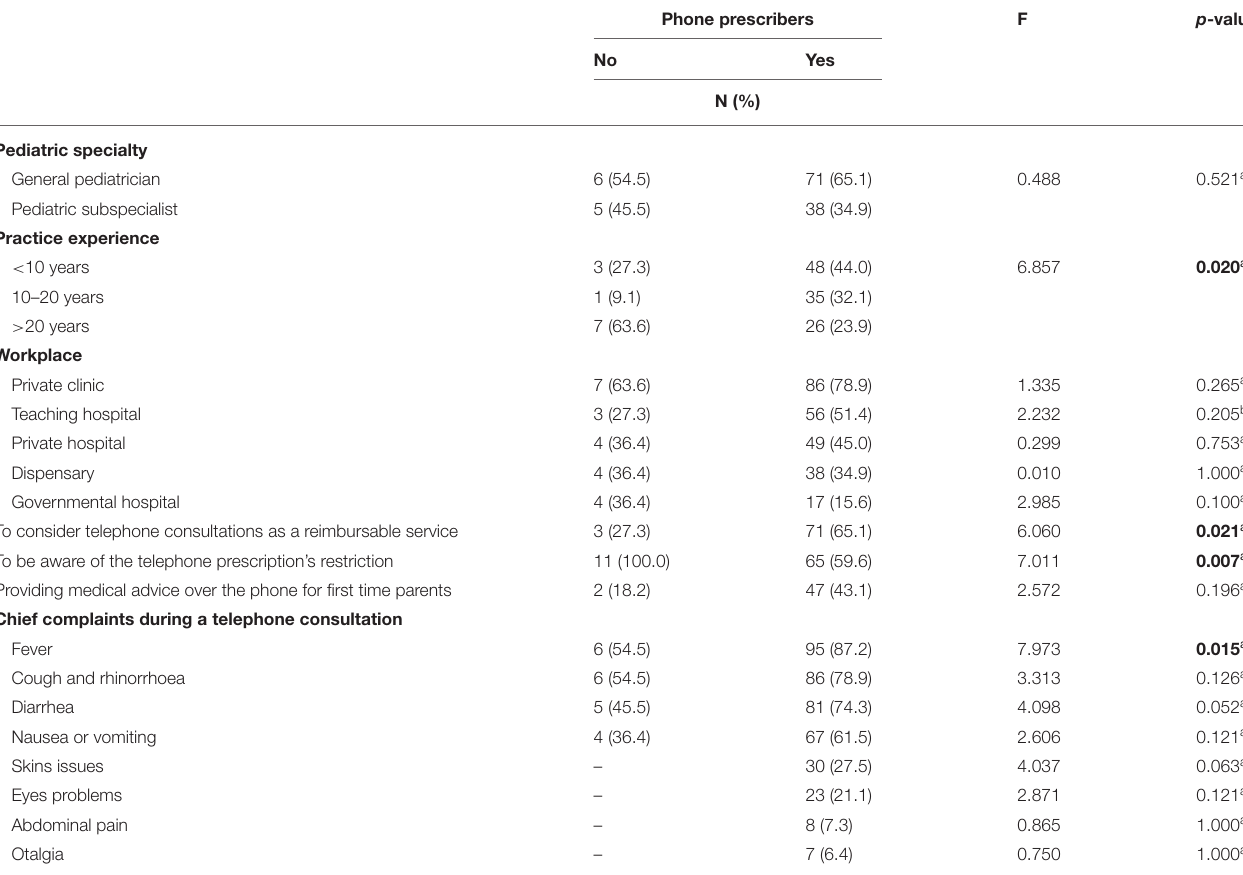
TABLE 2 | Distribution of collected variables regarding clinical practices and telephone consultations between phone prescribers and